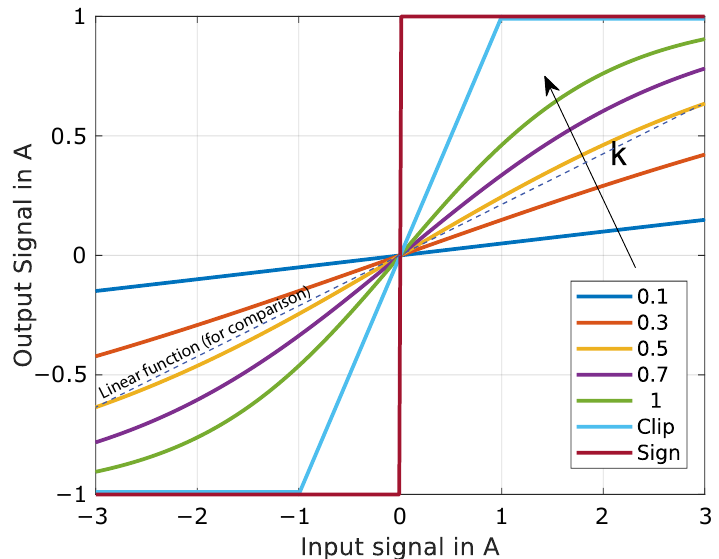
Figure 4. Characteristic of the considered transformation functions, including the sigmoid function (k = 0.1, 0.3, 0.5, 0.7, 1), the clip function, and the sign function.